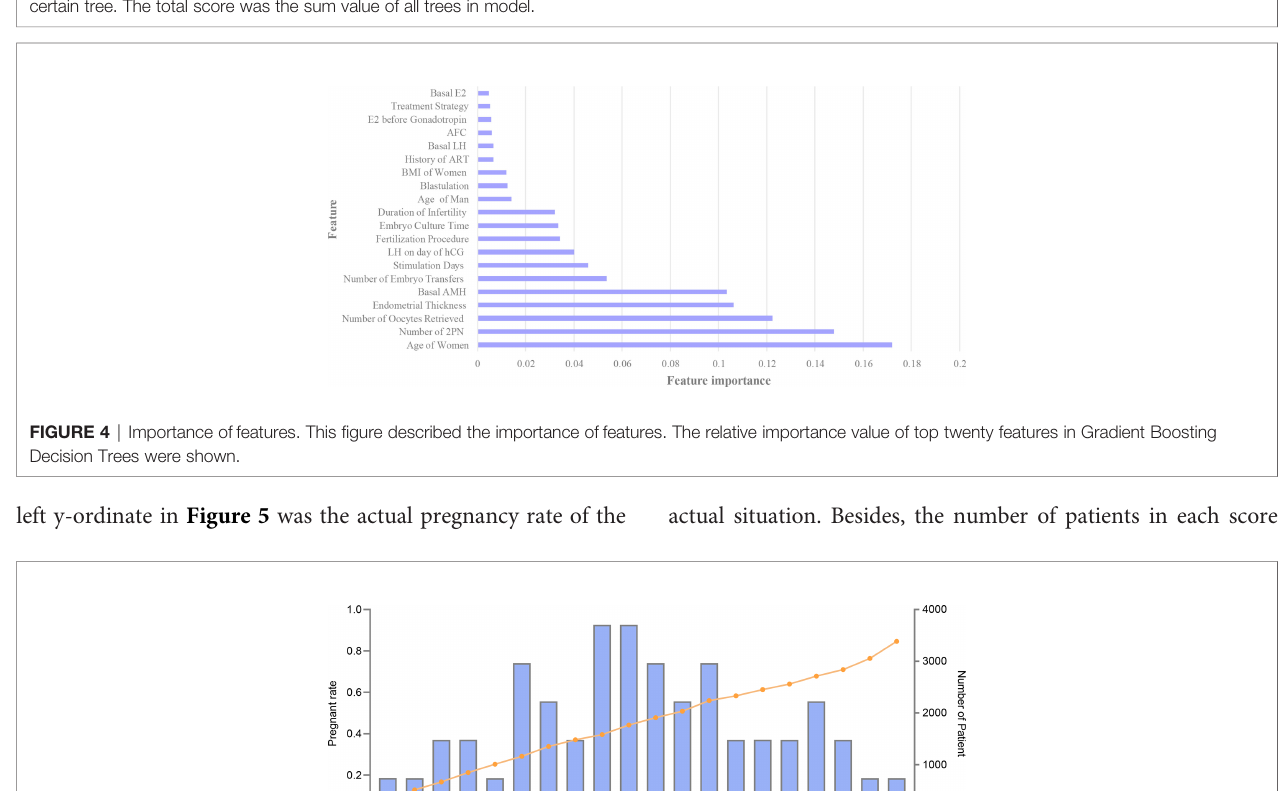
FIGURE 3 | Schematic diagram of the GBDT model. This fi gure described the schematic diagram of the GBDT model. For convenience, only one decision tree was displayed. Patients were assigned to different categories according to the decision criteria. The value represented the pregnant possibility in different categories in certain tree. The total score was the sum value of all trees in model.